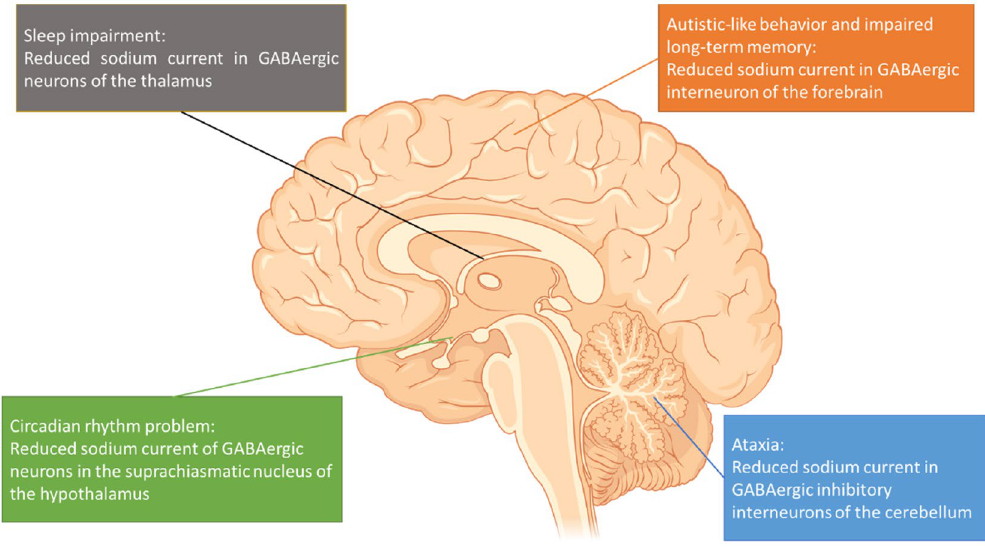
Figure 3. Schematic representation of the possible mechanisms of DS-associated comorbidities (partially created with https:// biore nder.